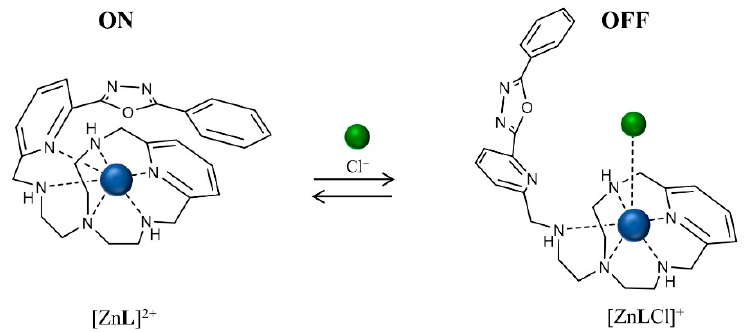
Figure 3. Proposed scheme for the formation of [ZnLCl] + species.